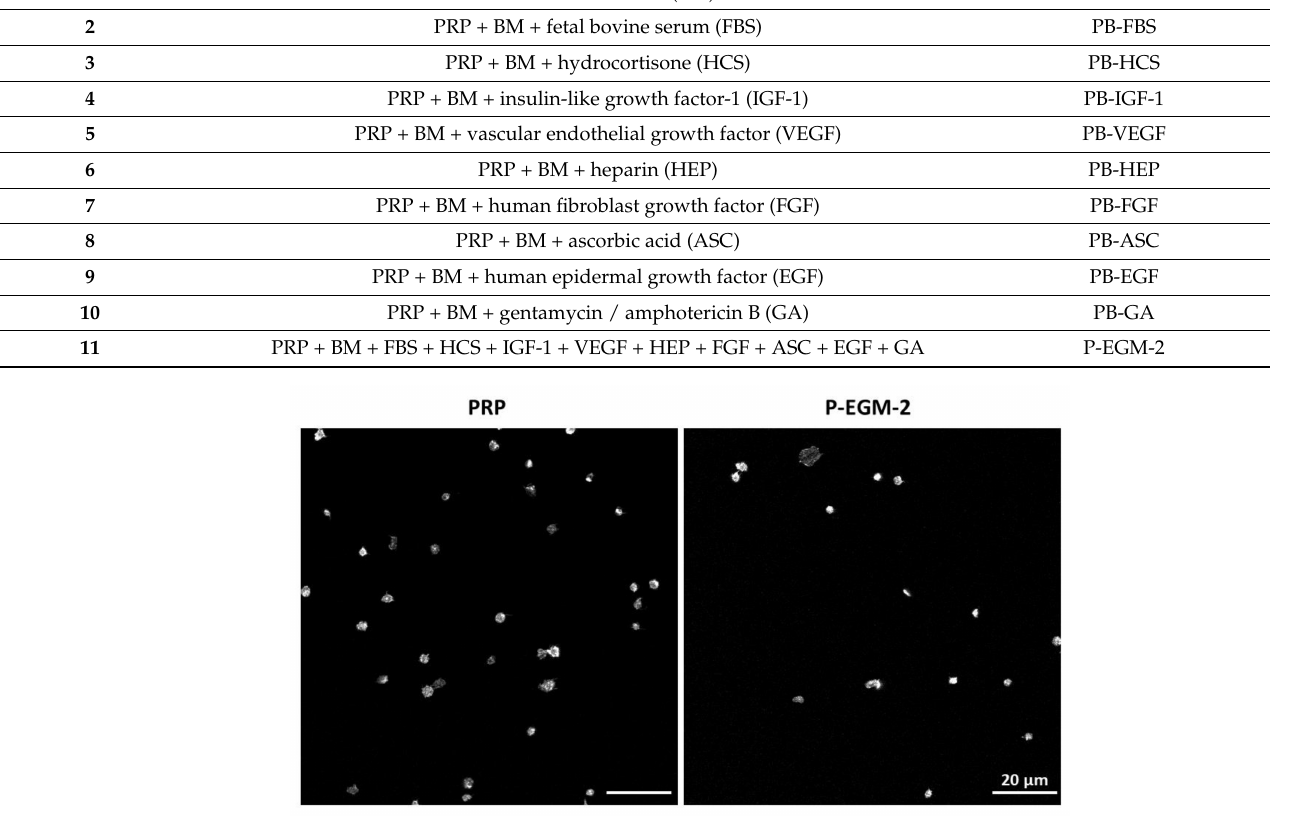
Figure 1. Adherence of platelets (PLT) on plasma-treated cyclic olefin copolymer (pCOC). Platelet-rich plasma (PRP) was incubated under static conditions for 1 h at 37 ◦ C with basal medium containing nine supplements (P-EGM-2) in a ratio of 1:1 resulting in a concentration of 50,000 PLT µ L − 1 . PRP served as control. PLT of six different donors were stained with phalloidin conjugated with Alexa Fluor 555 and images were taken by confocal laser scan microscopy at 100-fold primary magnification. As platelet adherence was similar for all six donors and for all supplements tested, representative images of PLT of one donor are shown for the complete medium (P-EGM-2) and for the control PRP. Scale bar represents 20 µ